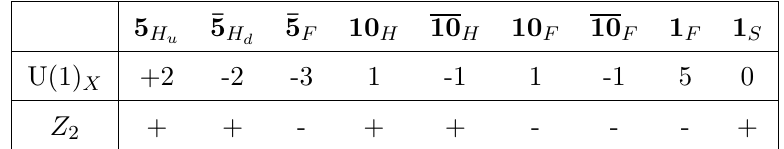
Table 1 . U(1) X and Z 2 charges of the di(cid:11)erent representations of (cid:13)ipped SU(5) gauge symmetry.